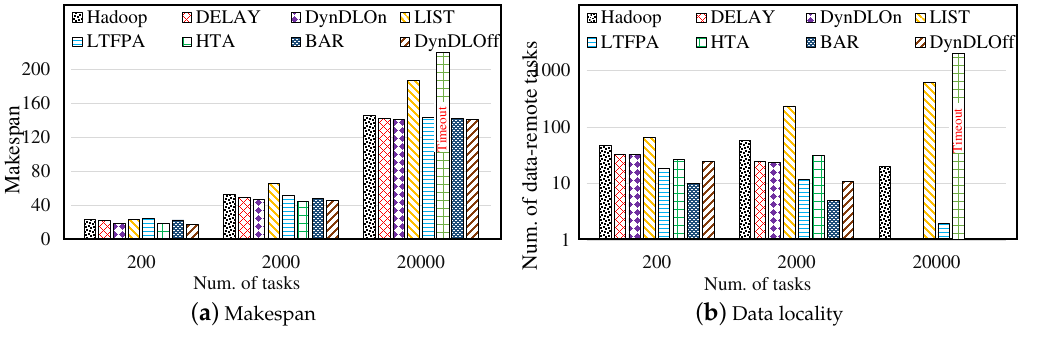
Figure 8. Effects of number of